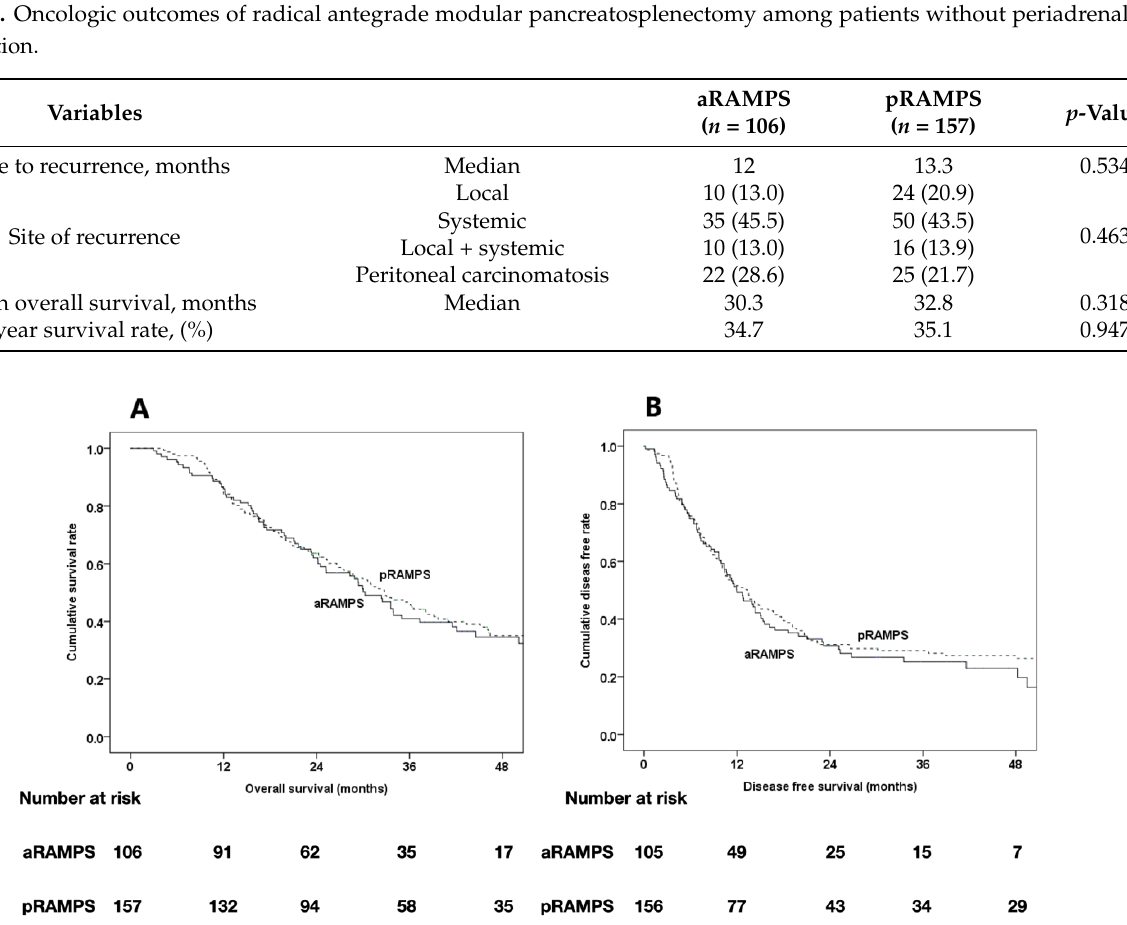
Table 7. Oncologic outcomes of radical antegrade modular pancreatosplenectomy among patients without periadrenal infiltration.